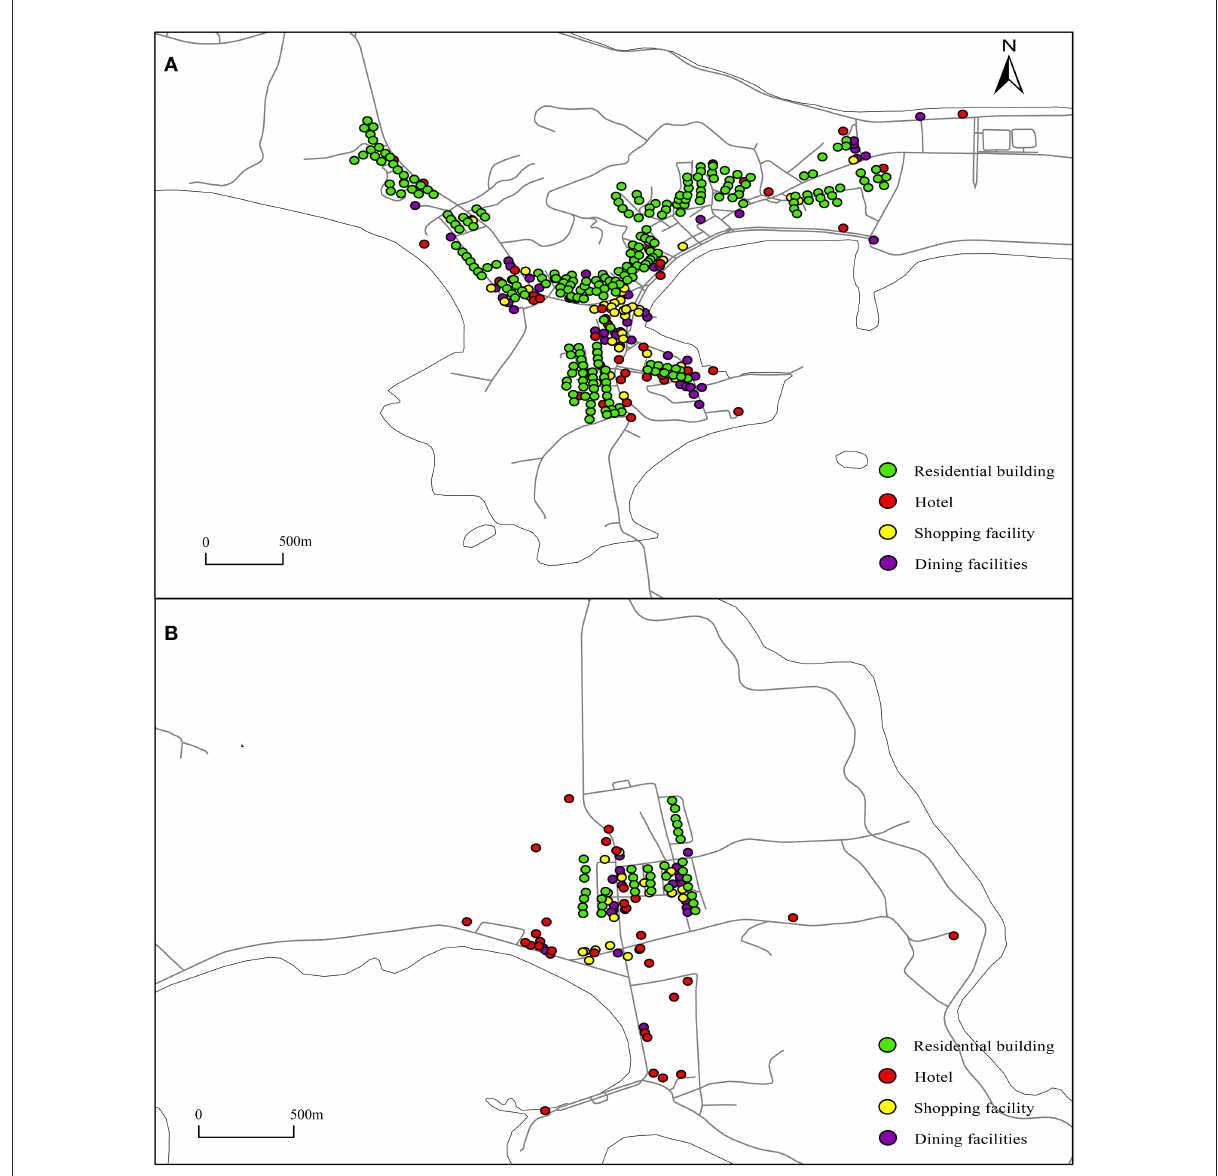
FIGURE2 Distribution of facilities in the study area. (A, B) The results are counted according to the number of the facilities, including catering and shopping facilities, hotel and residential